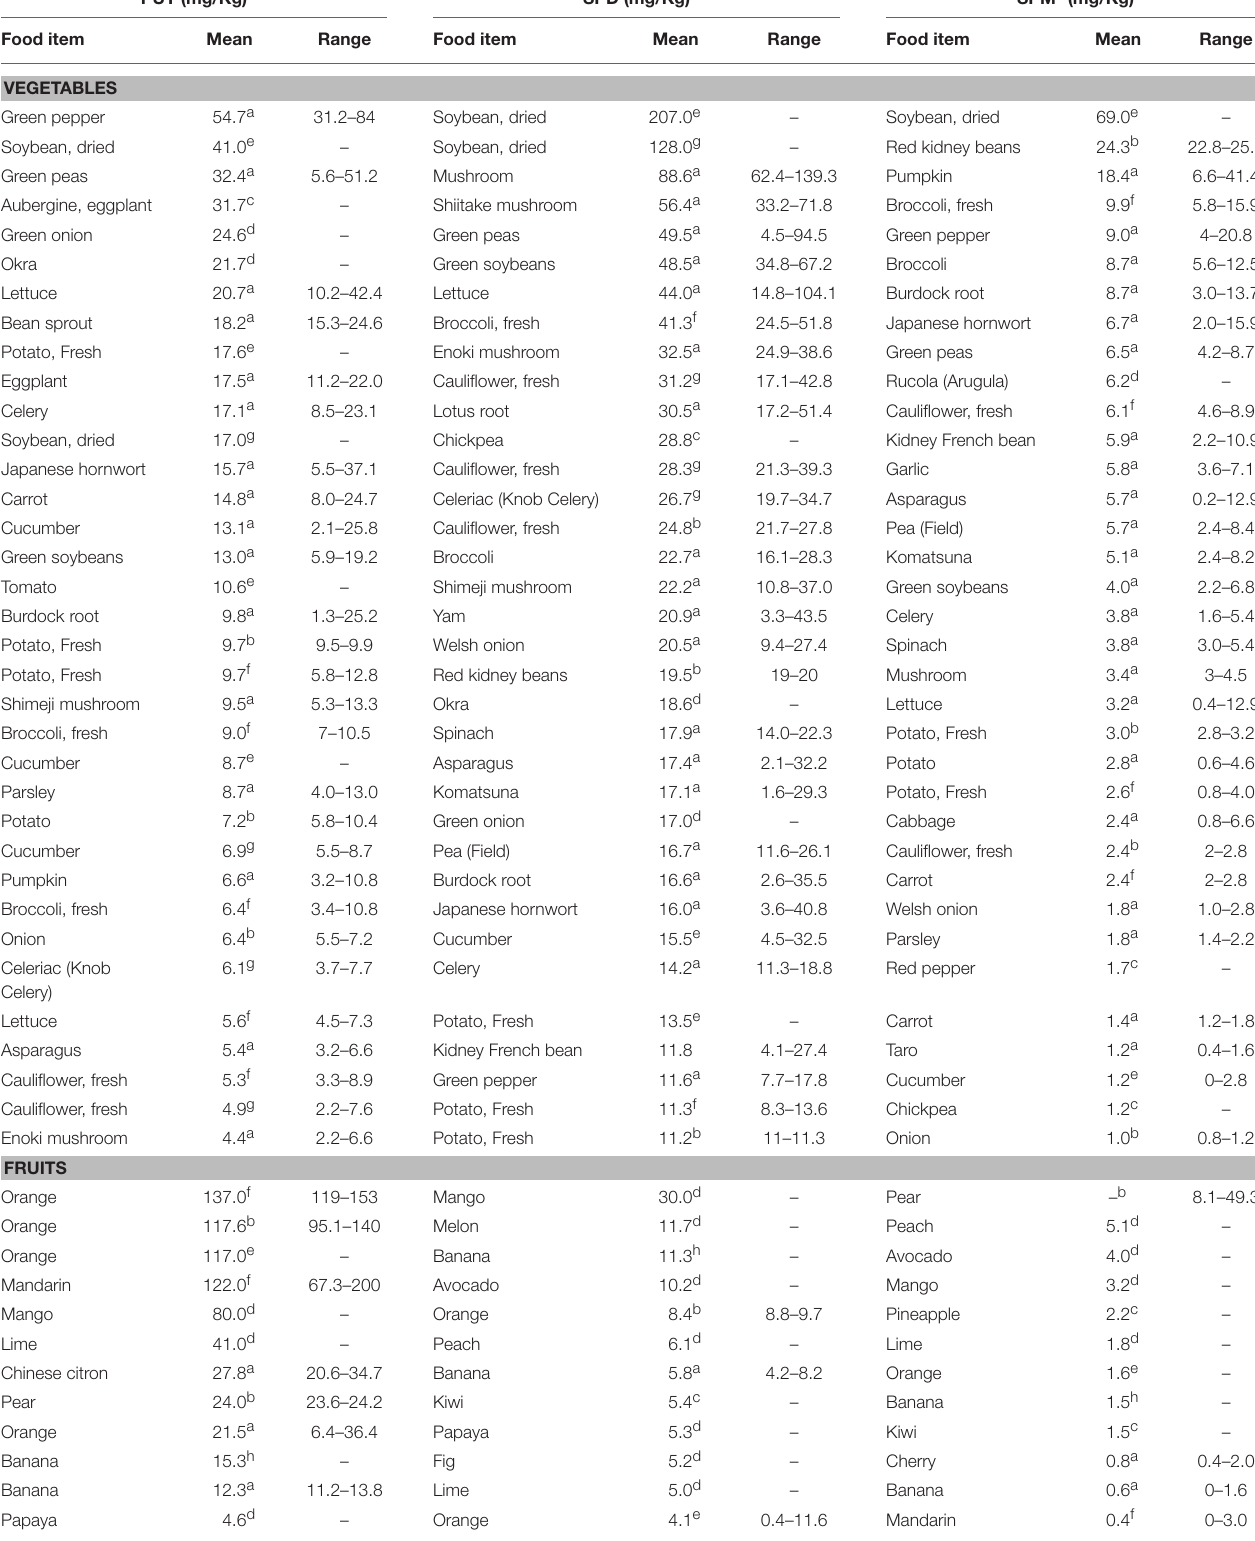
TABLE 1 | Polyamines content in vegetables, fruits, grains, and other plant based